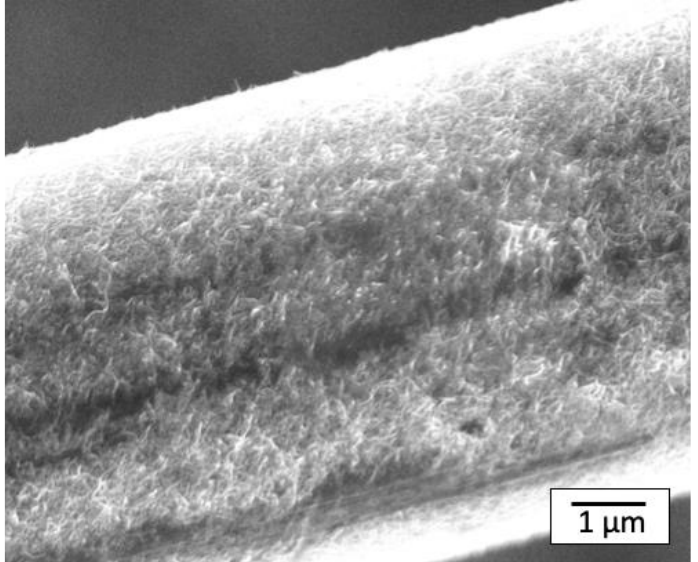
Figure 8. SEM image of the MWCNTs remaining on the CF surface. The sample was prepared using CF/Pipozo/MWCNT (layer-by-layer method, Figure 5), which was melt-mixed with PS and PS was then completely removed with a solvent treatment several times. This demonstrates that the MWCNTs (second layer) were strongly bonded to CF by Pipozo (first layer) and the MWCNTs were not removed by the melt-mixing process.